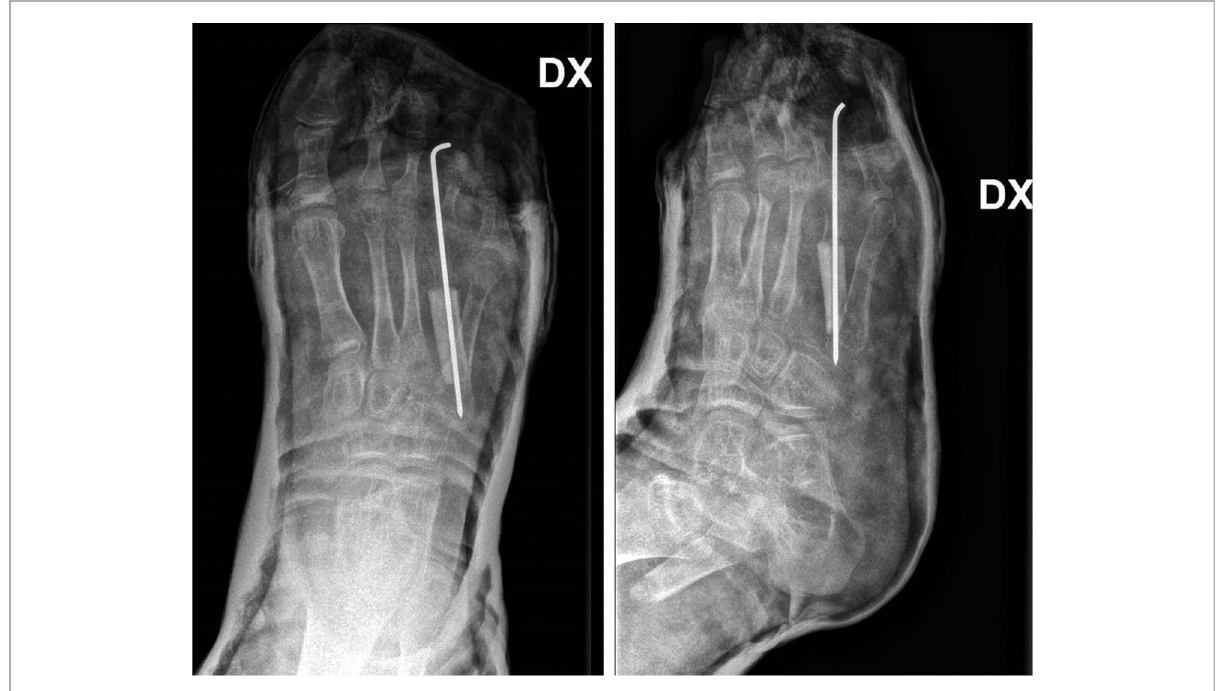
FIGURE 3 Post-operative x-ray A/P ( A ) and lateral ( B ) view showing reconstruction of IV metatarsal by fi bular graft fi xed to the base of V metatarsal (inverted Y shaped construct) using Kirschner ’ s wire and preserving tarso-metatarsal